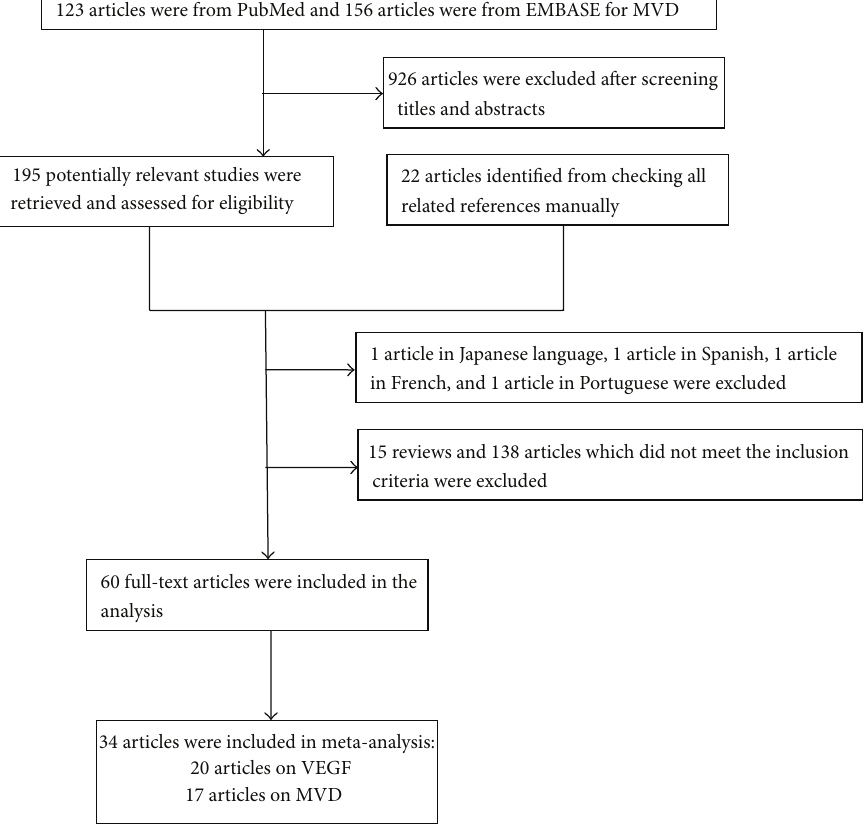
Figure 1: The flow diagram of the studies